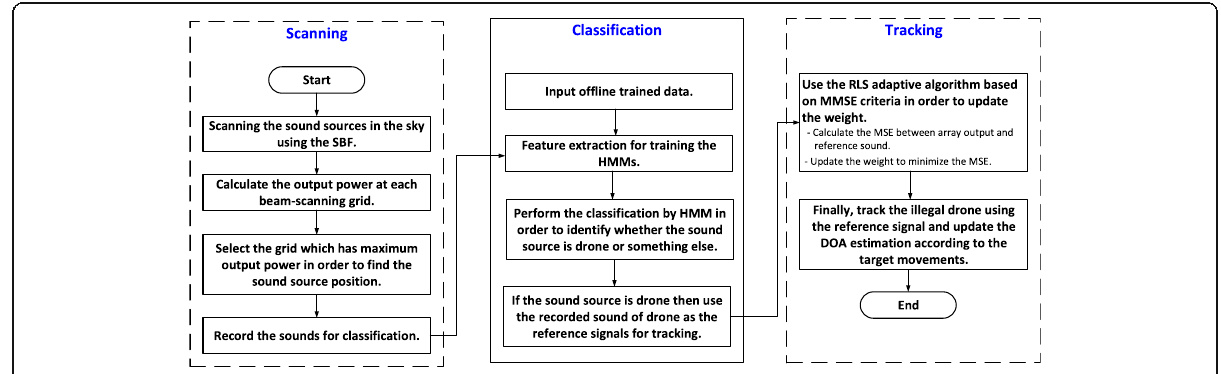
Fig. 3 Overall procedure of acoustic signal-based positioning of illegal